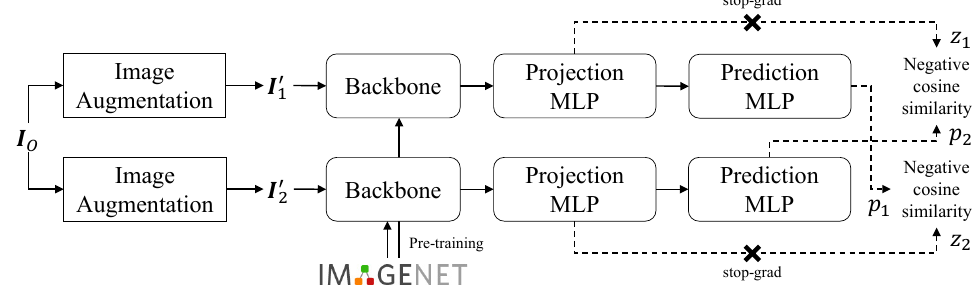
Figure 7. Image hashing network, where MLP is a Multi-Layer